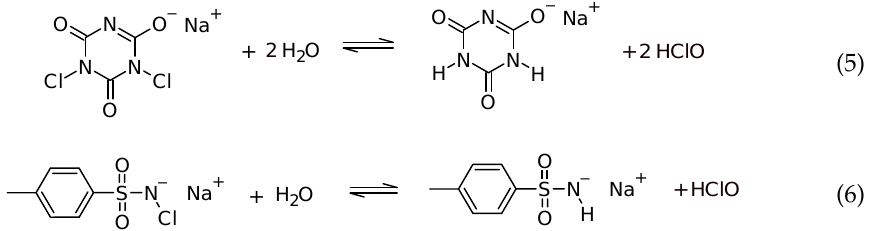
Figure 1. Curves of equilibrium concentrations of elemental chlorine (Cl 2 ), chloric acid (HOCl), and chlorate (I) ions (ClO − ) in aqueous solutions depending on the pH.